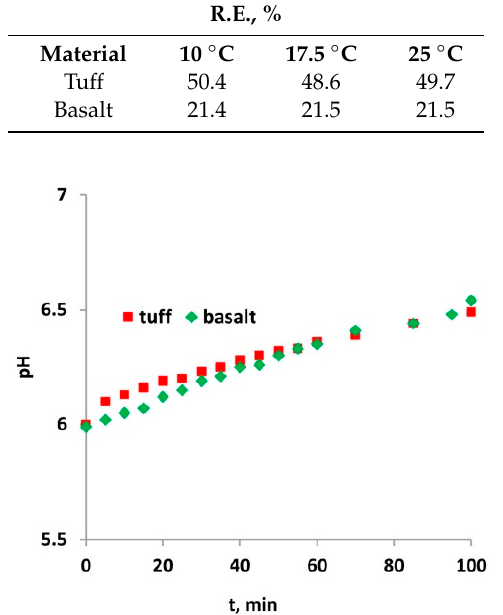
Table 3. R.E. of Mn sorption on tu ff and basalt at 10, 17.5 and 25 ◦ C in a state of equilibrium (tu ff –35 min, basalt–45 min).